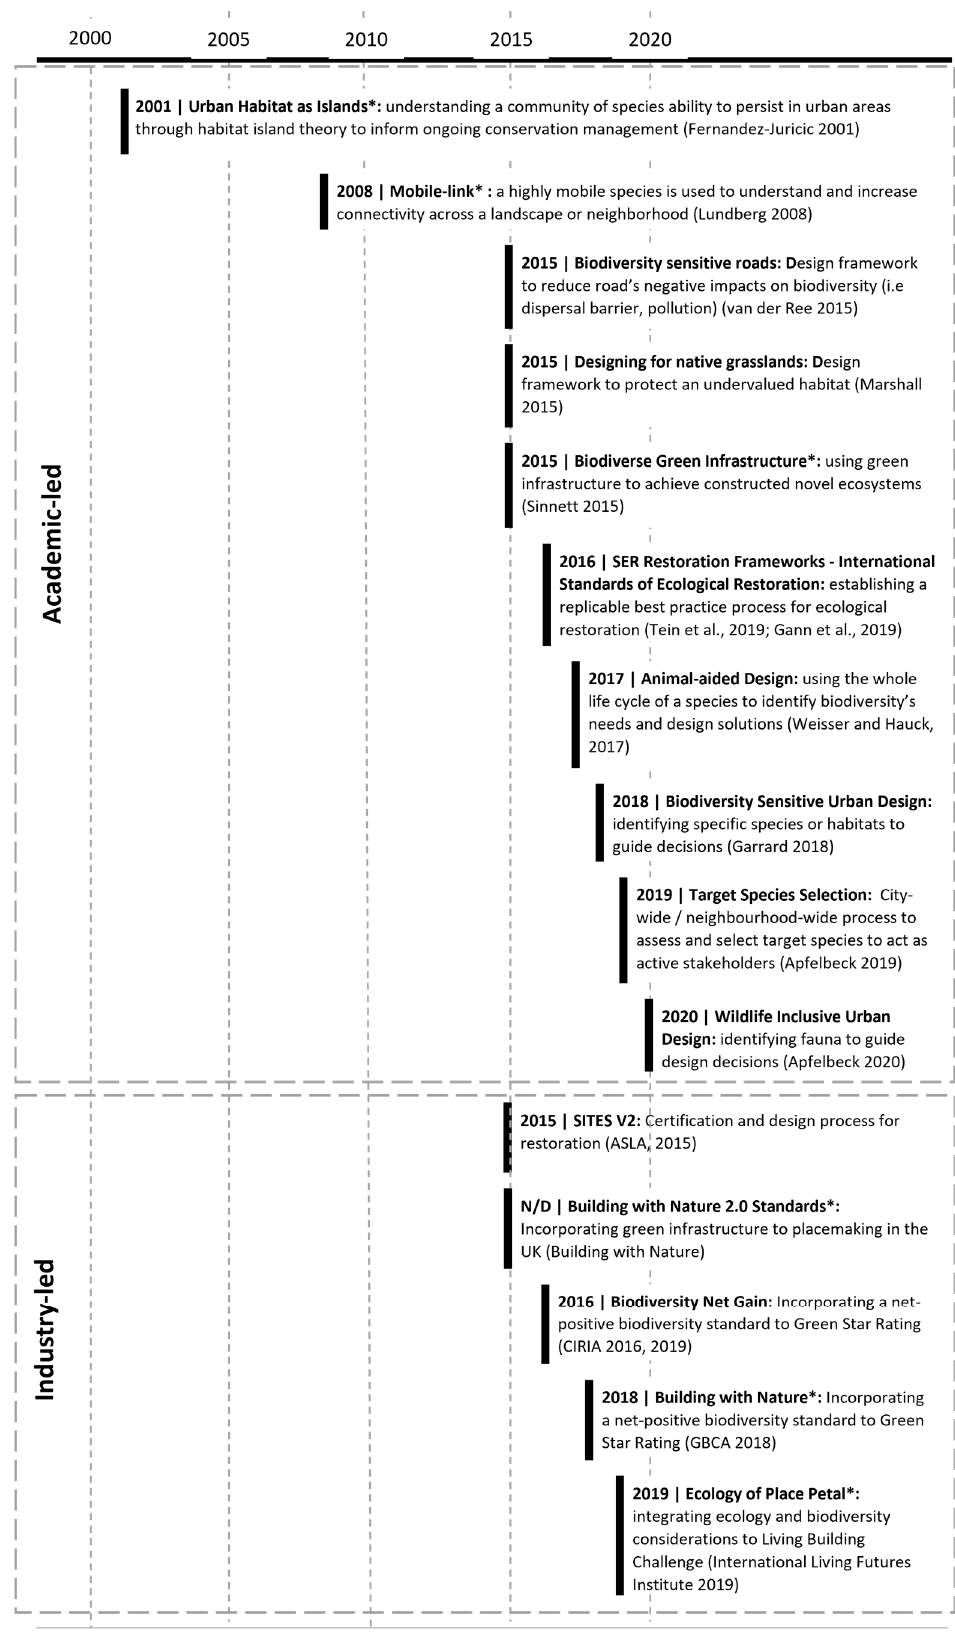
Figure 2. Frameworks developed between 2000 and 2020 that were evaluated in our research, categorised by their association to industry or academia * Denotes frameworks with inferred characteristics.